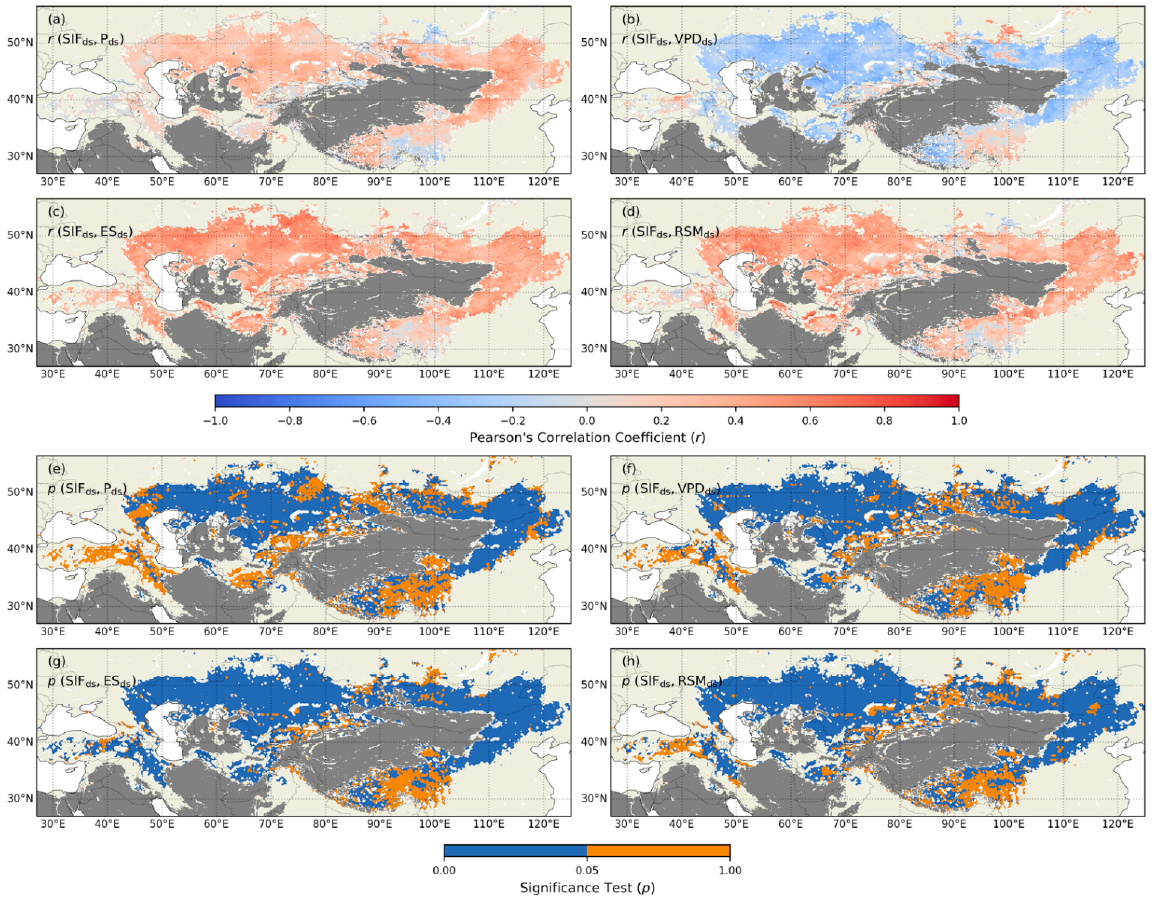
Figure 4. The spatial Pearson’s correlation coefficient ( r ) and corresponding significance test ( p ) of deseasonalized solar- induced chlorophyll fluorescence (SIF ds ) with deseasonalized precipitation, vapor pressure deficit, evaporative stress, and root zone soil moisture (P ds , VPD ds , ES ds , and RSM ds ). ( a – d ) respectively represented the spatial r of SIF ds with P ds ( r (SIF ds , P ds )), VPD ds ( r (SIF ds , VPD ds )), ES ds ( r (SIF ds , ES ds )), and RSM ds ( r (SIF ds , RSM ds )). ( e – h ) respectively represented the spatial p of SIF ds with P ds ( p (SIF ds , P ds )), VPD ds ( p (SIF ds , VPD ds )), ES ds ( p (SIF ds , ES ds )), and RSM ds ( p (SIF ds , RSM ds )).